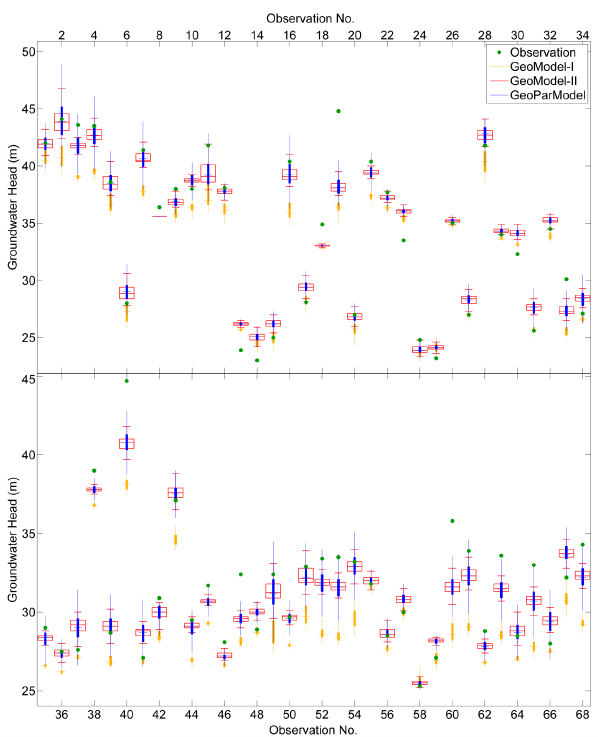
Fig. 10. Boxplot of simulated hydraulic heads against 68 observations from head obs. group 1. Green dots are observed groundwater head, yellow color plots represent simulations from 90 GeoModel-I, red color plots represent simulations from 90 GeoModel-II, and blue color plots represent simulations from GeoParModel. The edges of the boxes are the 25th and 75th percentiles, and the whiskers extend to the 2.5th and 97.5th percentiles.